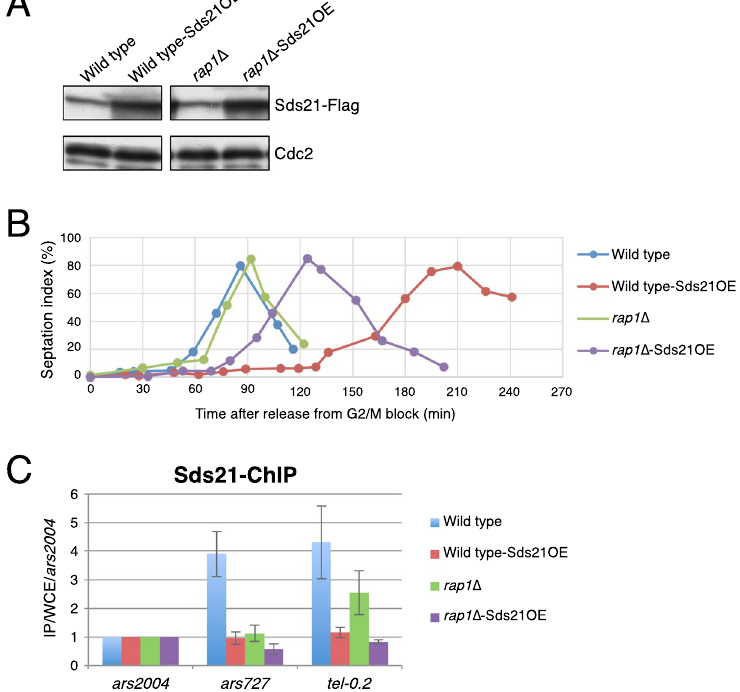
Figure 5. Overexpression of Sds21 causes severe defects in cell cycle progression. ( A ) Expression level of Sds21-3Flag protein in each strain. Wild type, Sds21-overexpressing wild type (wild type-Sds21OE), rap1 ∆ , and Sds21-overexpressing rap1 ∆ ( rap1 ∆ -Sds21OE) cells were grown in EMM. The whole-cell extracts were analyzed by immunoblotting using anti-Flag (M2 F3165; Sigma-Aldrich) for Sds21-3Flag and anti-PSTAIRE (P7962; Sigma-Aldrich) for Cdc2 (loading control). ( B ) Representative septation index after release from G 2 /M block. ( C ) Wild type, wild type-Sds21OE, rap1 ∆ , and rap1 ∆ -Sds21OE cells were grown in EMM medium, and ChIP analyses of Sds21-3Flag localization were performed with cells in early S phase, i.e., at 60 min (for wild type and rap1 ∆ ), 130 min (for wild type-Sds21OE), and 80 min (for rap1 ∆ -Sds21OE) after released from G 2 /M arrest. Co-purified genomic DNA was analyzed by qPCR. Each value was normalized to that of ars2004 . Error bars indicate the s.d. ( n =